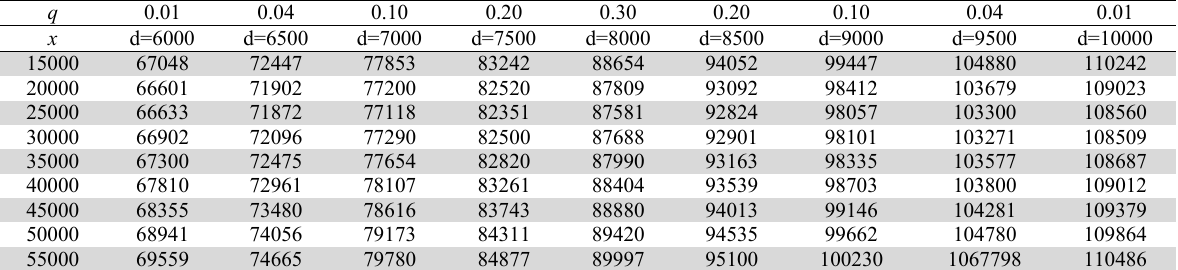
Results of simulation model for EOQ